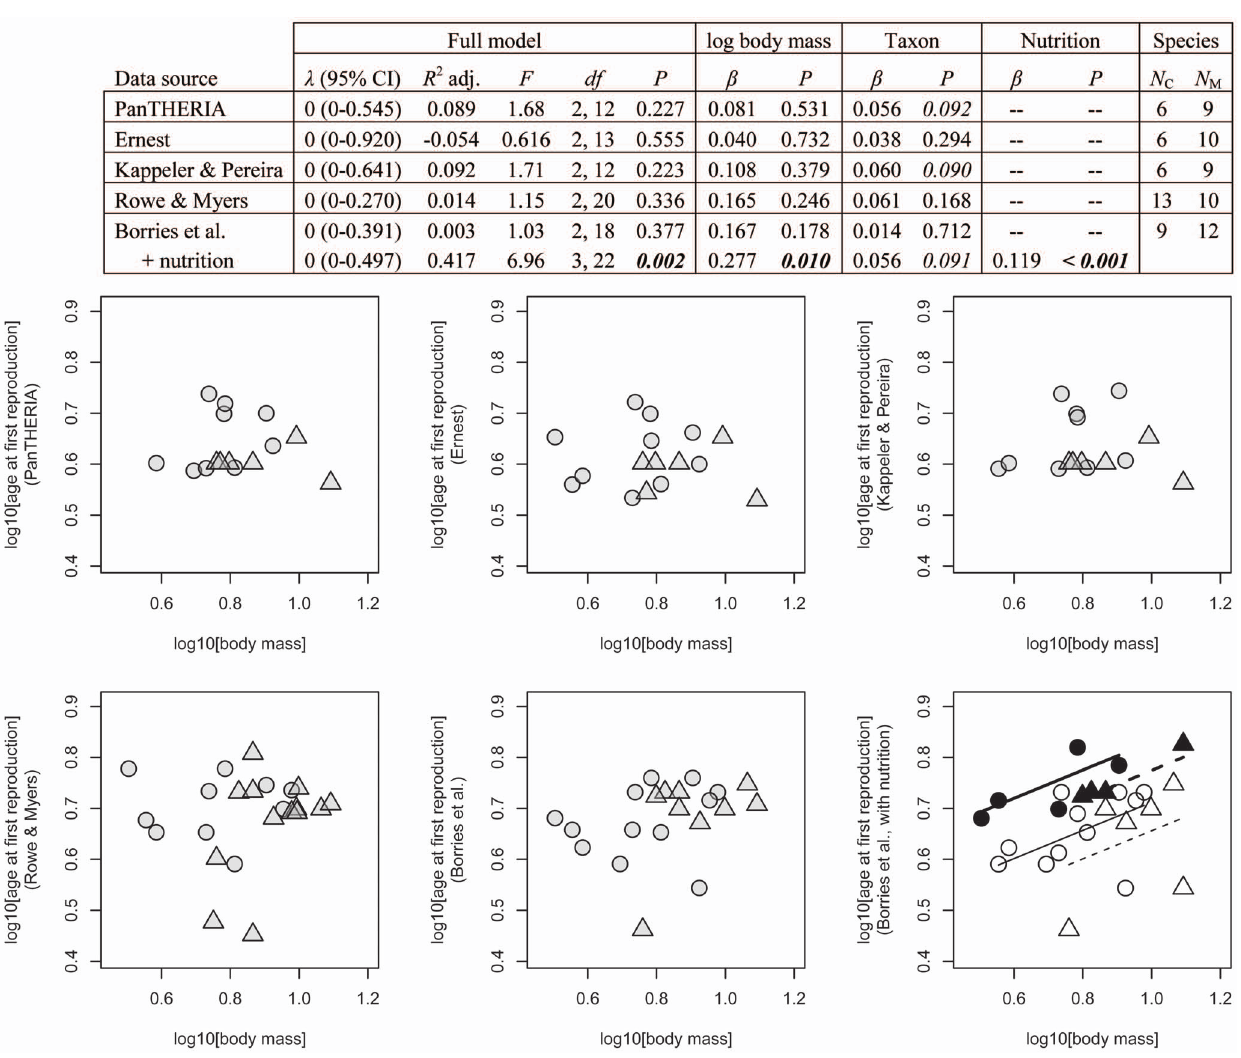
Figure 3. Age at first reproduction [log10 years] in relation to adult female body mass [log10 kg] for different databases. Symbols and abbreviations as in Fig. 2.